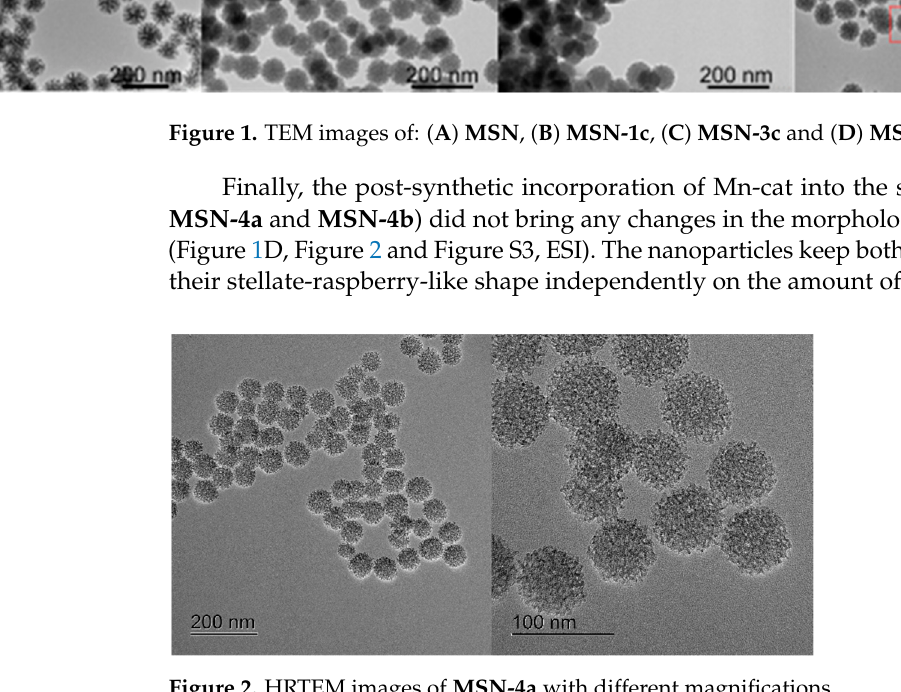
Figure 2. HRTEM images of MSN-4a with different magnifications. Table 2. Chemical and morphologic characteristics of the nanoparticles.